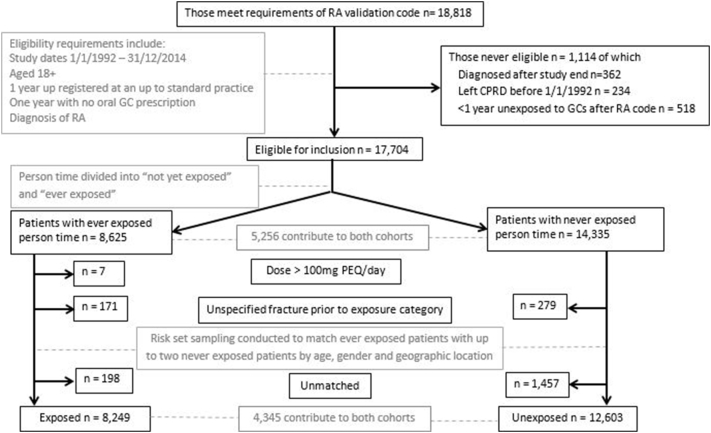
Flow chart of the selection of the study population.